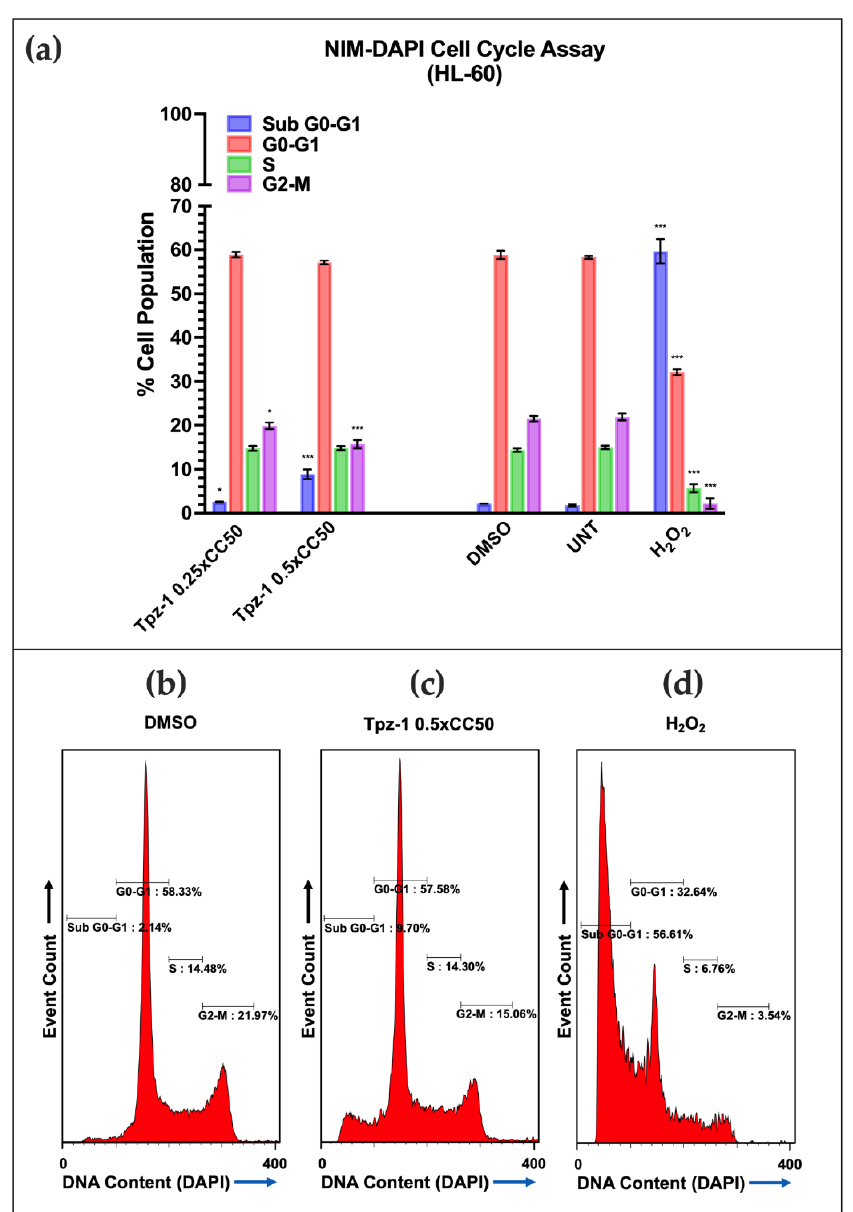
enon is shared or unique to HL-60 cells.